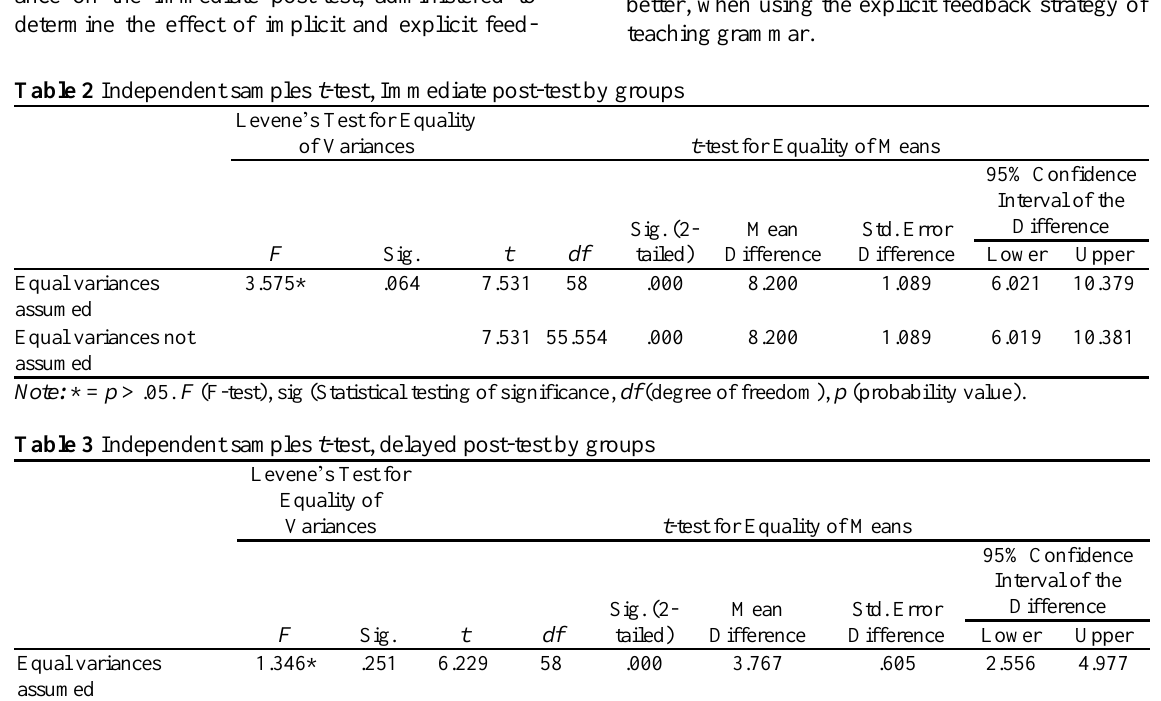
Table 2 Independent samples t -test, Immediate post-test by groups Levene’s Test for Equality of Variances t -test for Equality of Means